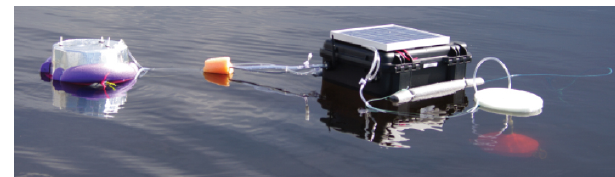
Figure 1. The photo of a deployed AFC–ABC device shows a float- ing control box that houses the electronics, a floating chamber, and a submerged